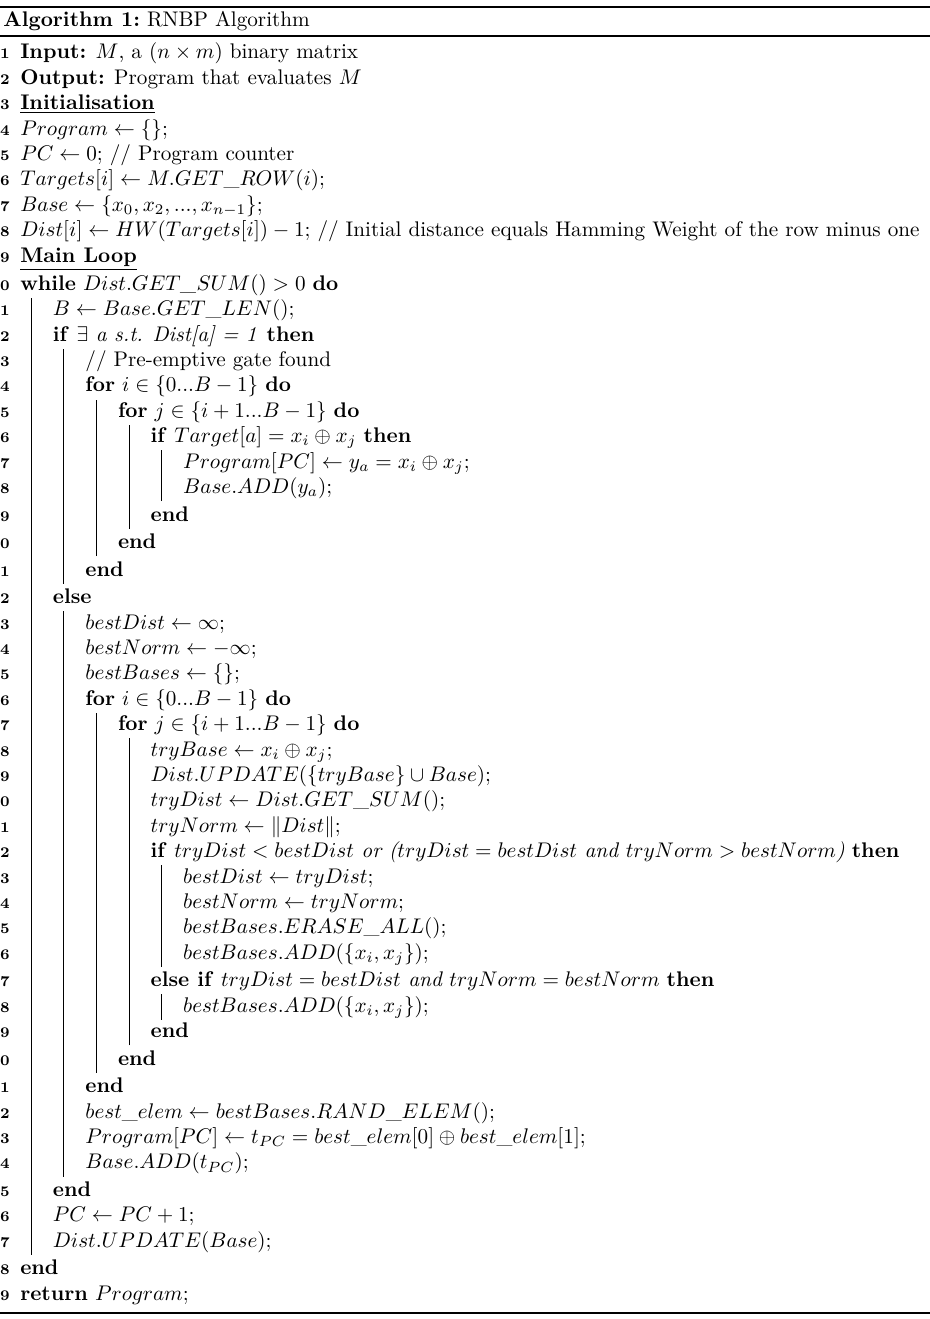
Algorithm 1: RNBP